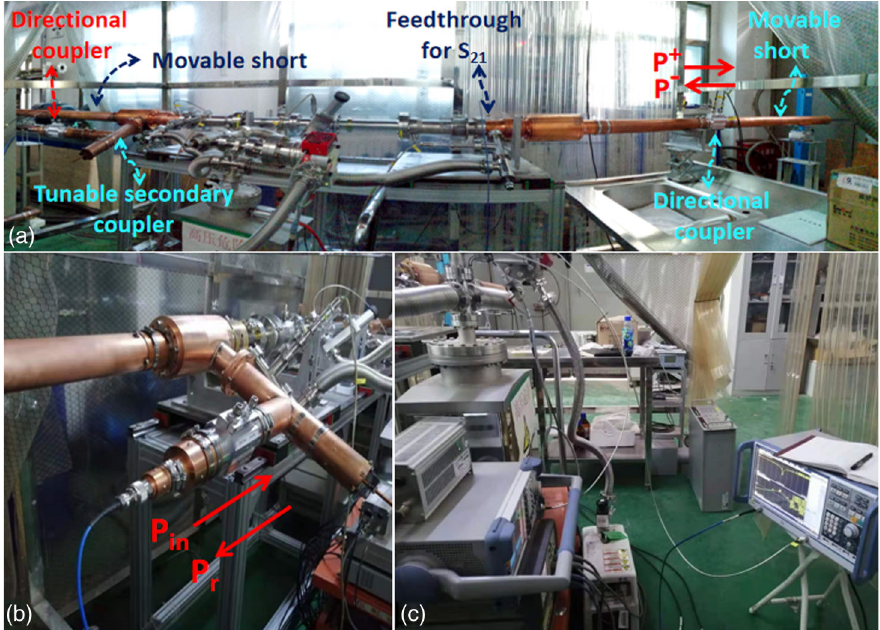
FIG. 16. Proof-of-principle structure of the test system under the low-power tests. (a) gives the overall view of the resonant test system; (b) depicts the secondary coupler; (c) shows the VNA utilized in the low-power tests.